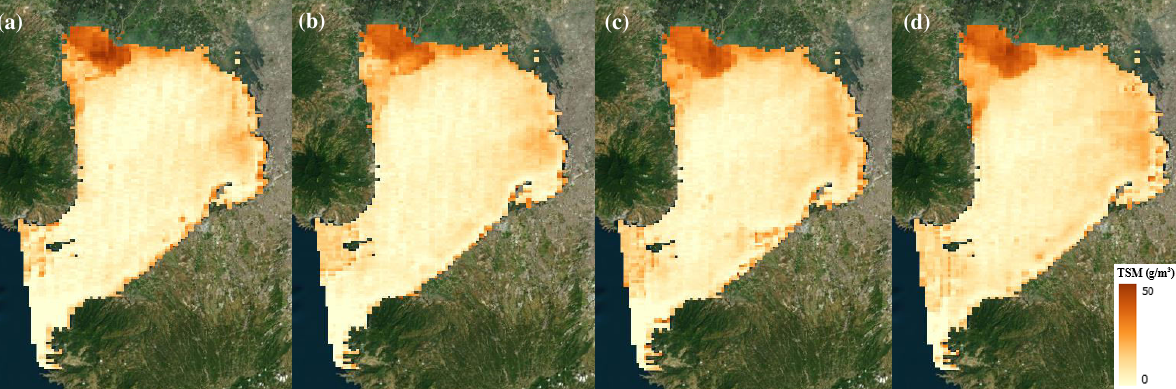
Figure 12. TSM maps for September 26, 2019 using the Yearly model: (a) 9:10, (b) 9:30, (c) 9:50, and (d) 10:10